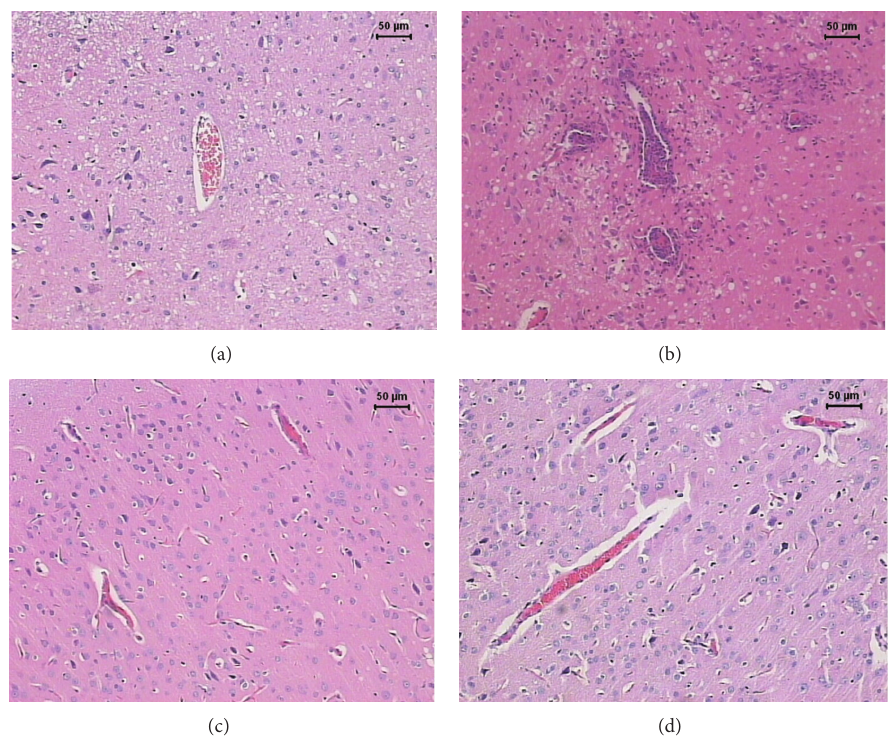
Figure 2: Effect of tuberculosis vaccines in brain inflammation associated with EAE. Female Lewis rats were immunized with BCG alone or with BCG followed by pVAXhsp65 boosters and then underwent EAE induction by inoculation of MBP emulsified with CFA. Animals were euthanized during the recovery phase (20th day after MBP injection) and the brains were removed and further stained by haematoxylin and eosin. Normal control (a), EAE control (b), rats immunized with BCG before EAE (c), and rats immunized with BCG/pVAXhsp65 before EAE induction (d).